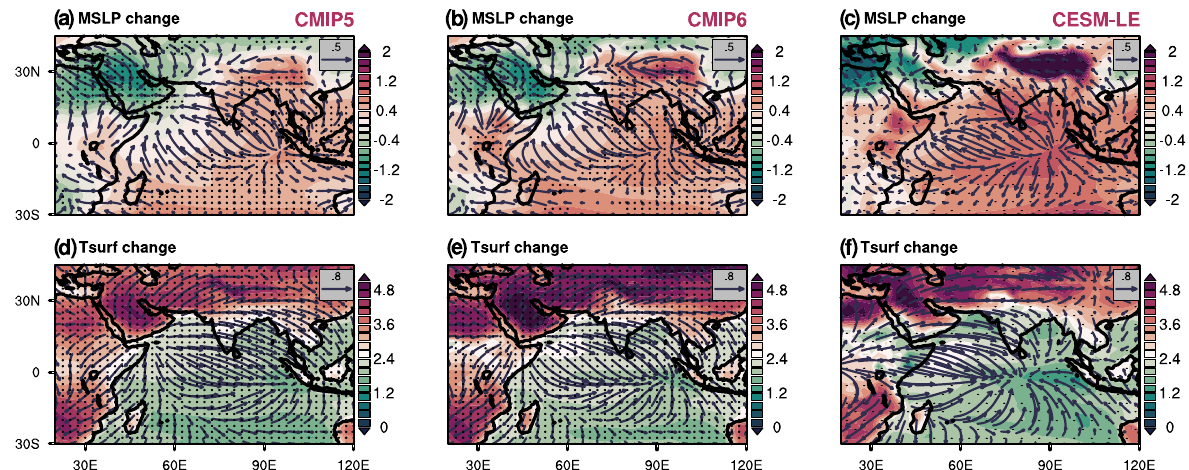
Fig. 3 Contribution of anomalous local meridional circulation to the IWC weakening. Ensemble mean changes (RCP8.5 minus historical) in a MSLP (hPa, shaded) and divergent winds (m/s, vectors) at the surface level (1000 hPa), d Tsurf ( o C, shaded), and divergent winds (m/s, vectors) at the upper level (200 hPa) for CMIP5 (24 models). b , c Same as in ( a ) but for CMIP6 (17 models) and CESM-LE (40 members), respectively. e , f as in ( d ), but for CMIP6 (17 models) and CESM-LE (40 members). Stippling in ( a , b , d , e ) indicates the areas where at least 70% of CMIP5 and CMIP6 models analyzed in this study exhibit the same sign as the ensemble mean changes. Stippling in panels c and f indicate the regions where the difference in MSLP between future and historical changes is signi fi cant at 95% con fi dence level based on a two-sample t test on the time series of ensemble